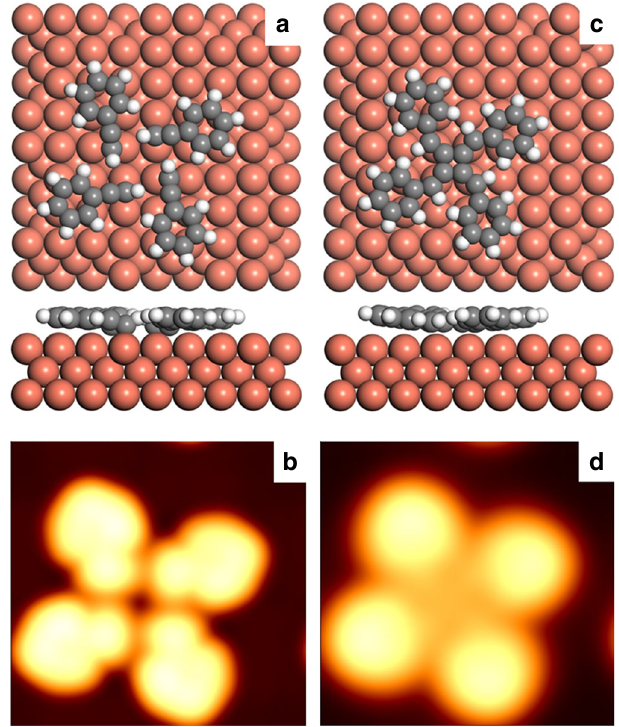
Fig. 3 Optimized structure and STM simulation of self-assembled and covalent connected products. a , b The optimized structure and the corresponding simulated STM image ( V b = 2.0 V) of the molecular assembly of four phenylacetylene molecules on the Cu(100) surface. c , d The optimized structure and the corresponding simulated STM image ( V b = 2.0 V) of the covalently bonded tetramer on the Cu(100) surface. Color code: Cu (brown), C (gray), and H